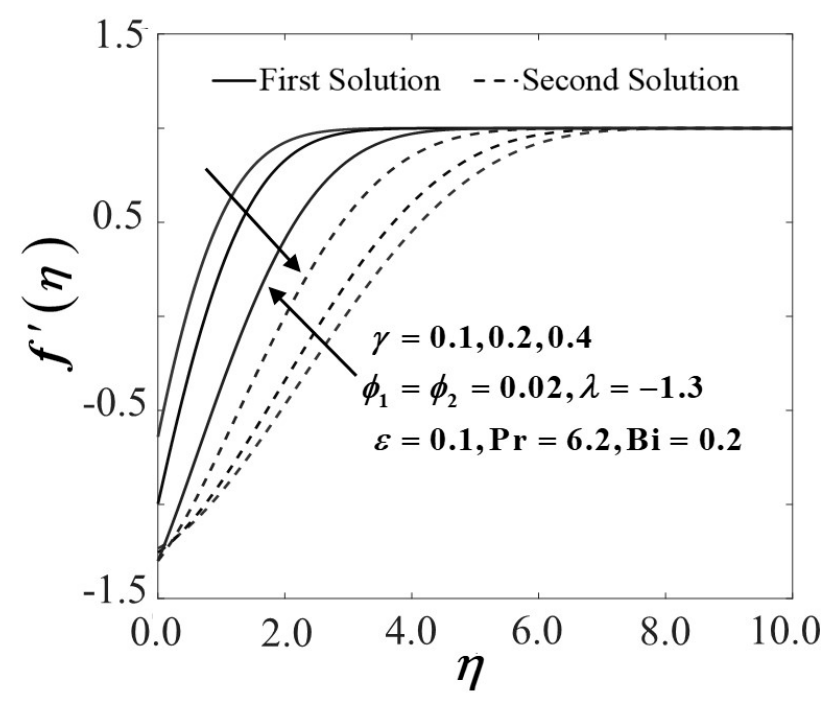
(cid:48) ( η ) with λ = − 1.3 (shrinking case). ( ) f η′ with 1.3 λ = − (shrinking case). Figure 4. Velocity profiles of f